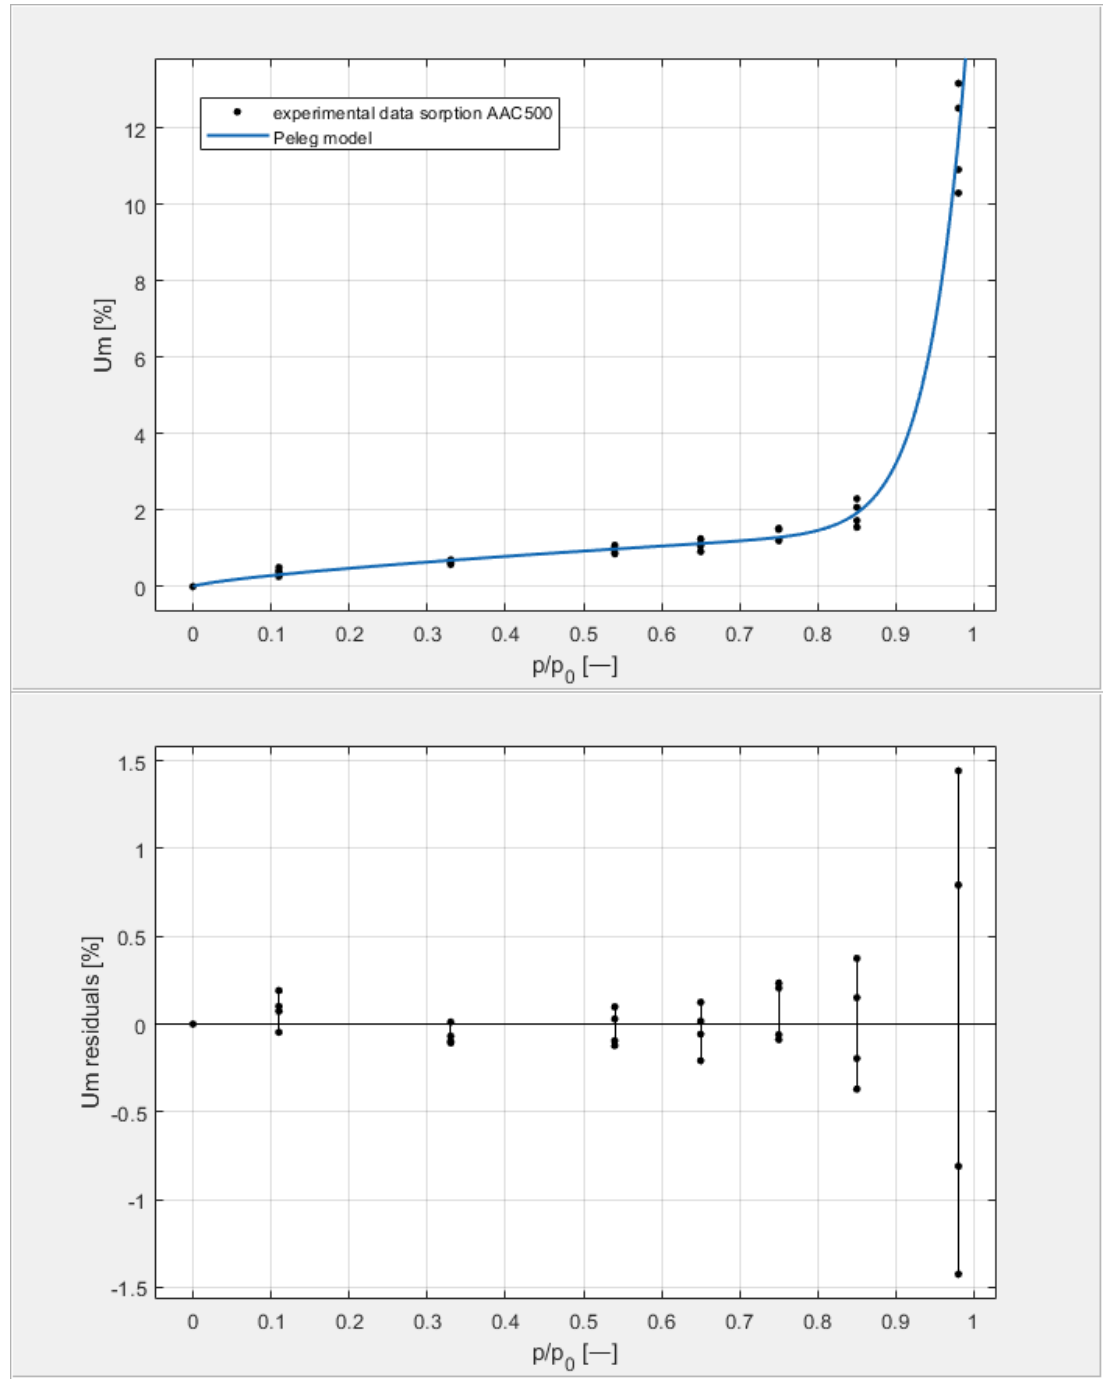
Figure 10. The sorption isotherms of class 500 aerated concrete described by the Peleg equation, plotted with the approximation error.